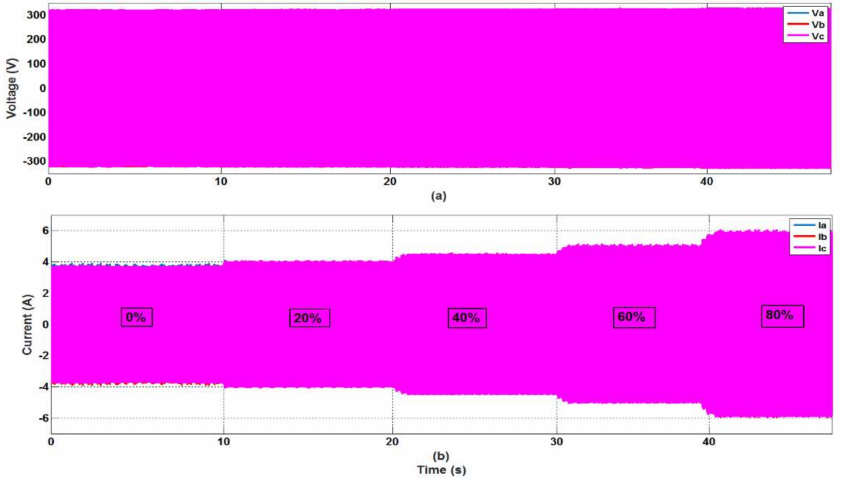
Figure 8. IM voltage and current waveforms for a balanced supply condition, under different step load variations.